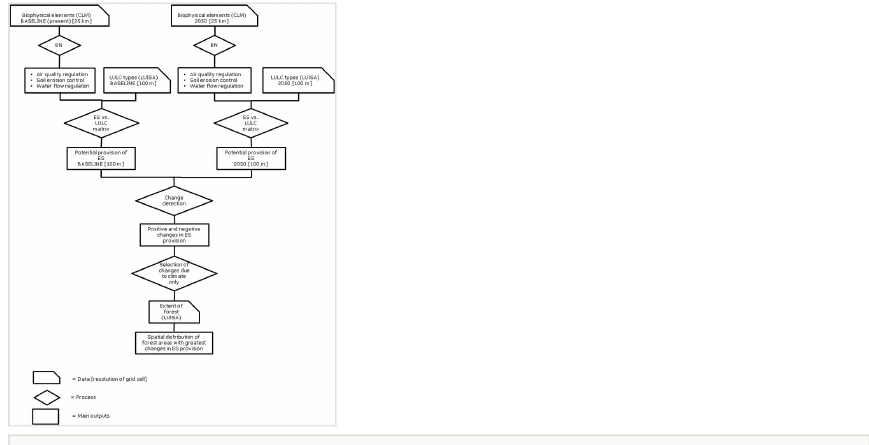
Figure 2. Main data, processes and outputs to estimate changes in ES provision. When relevant, sources of data are indicated within round brackets () and de fi ned within the main text. The spatial resolution of information from LUISA and CLM is speci fi ed within square brackets []. BN = Bayesian Network; ES = Ecosystem Service(s); LULC = Land use / land